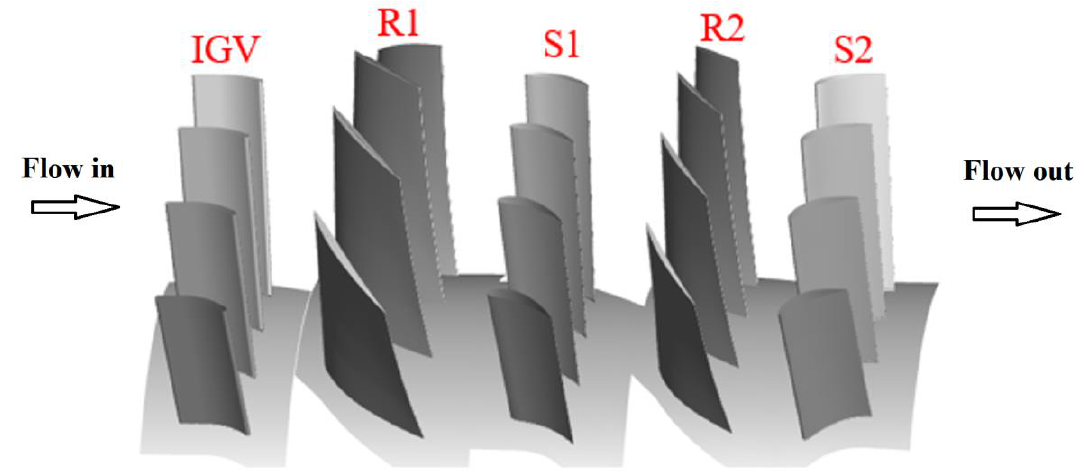
Figure 1. Cascades in the computational domain.